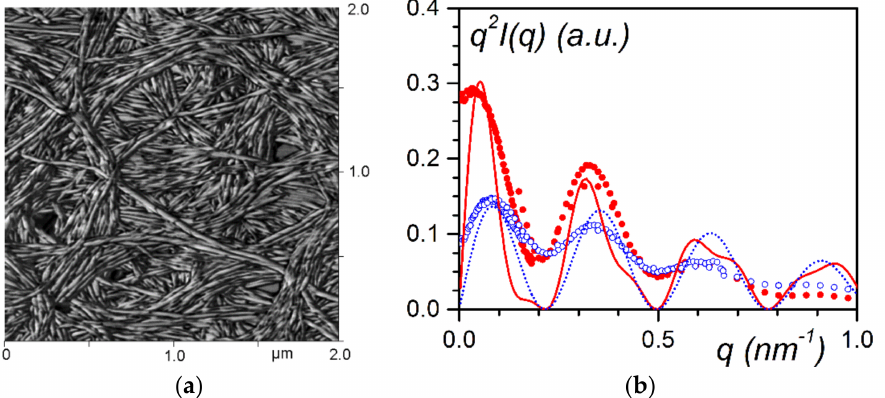
Figure 8. ( a ) AFM picture of nanotubes formed in trans-decahydronaphthalene (Guenet unpublished data); ( b ) Scattering curves plotted by means of a Kratky representation q 2 I(q) vs. q [25]; ( ) phbp-10/trans-decahydronaphthalene D system, ( ) iPS D /bhpb-10/trans-decahydronaphthalene D (cid:35) hybrid gel. Blue dotted line = fit with Equation (5), red solid line = fit with Equation